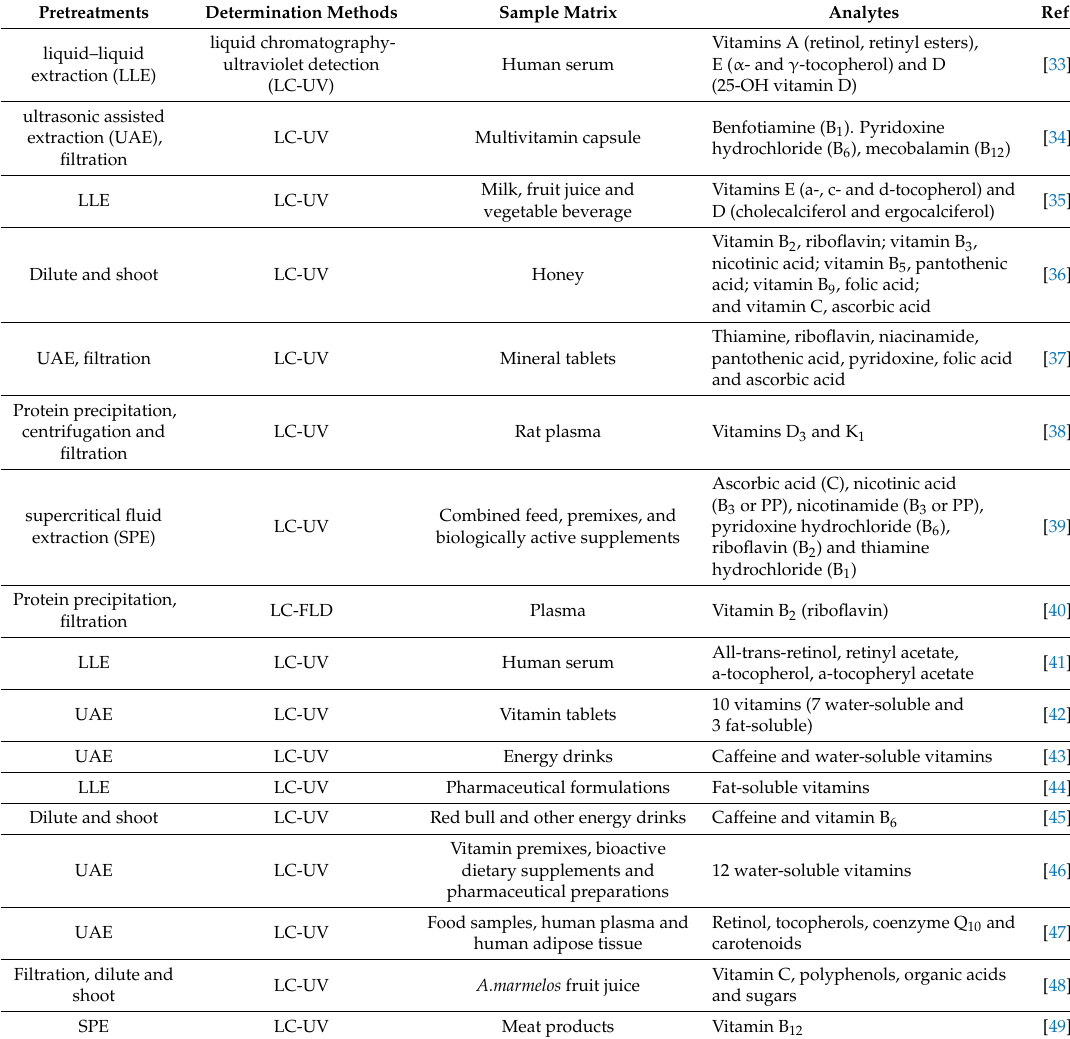
Table 3. Pretreatment methods, sample matrices and targets of the recent